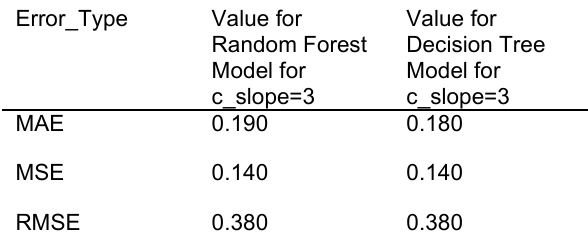
Table 8. Values of MAE, MSE, RMSE for overall data set for the Random Forest and Decision Tree Models for c_slope=3